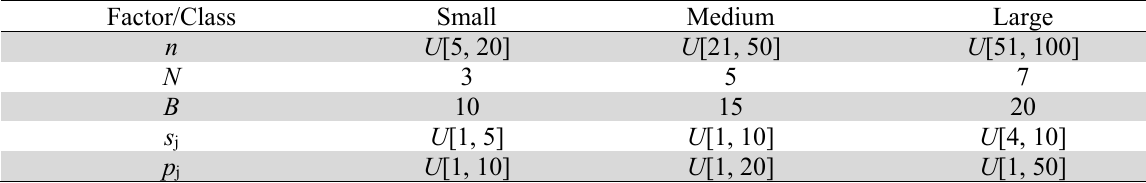
The different values of TL size for different number of jobs From